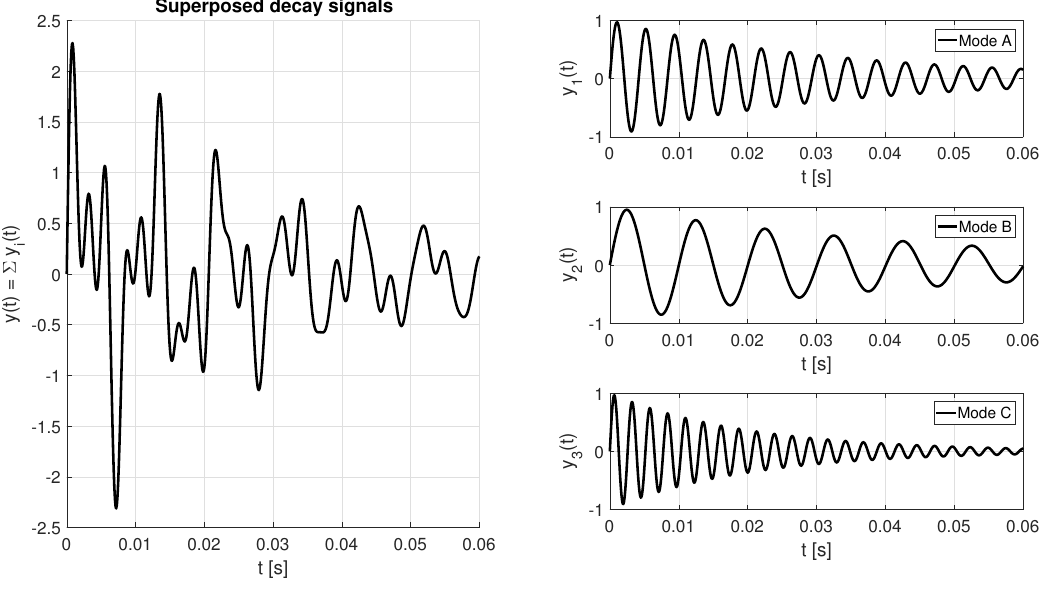
Figure 5. Superposed damped oscillations.